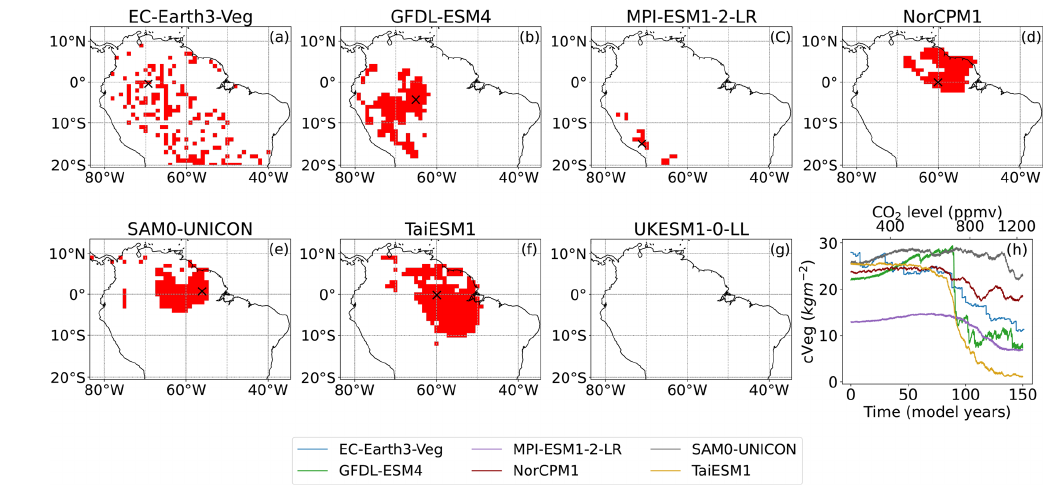
Figure 1. Abrupt shifts detected in the Amazon by the described algorithm and example time series for dieback shifts. (a–h) Maps of detected abrupt shifts. Grid points coloured red indicate detected abrupt dieback shifts where the direction of the overall trend and the abrupt shift are both negative. (h) Example time series for detected dieback shifts in each model, corresponding to grid points highlighted by black